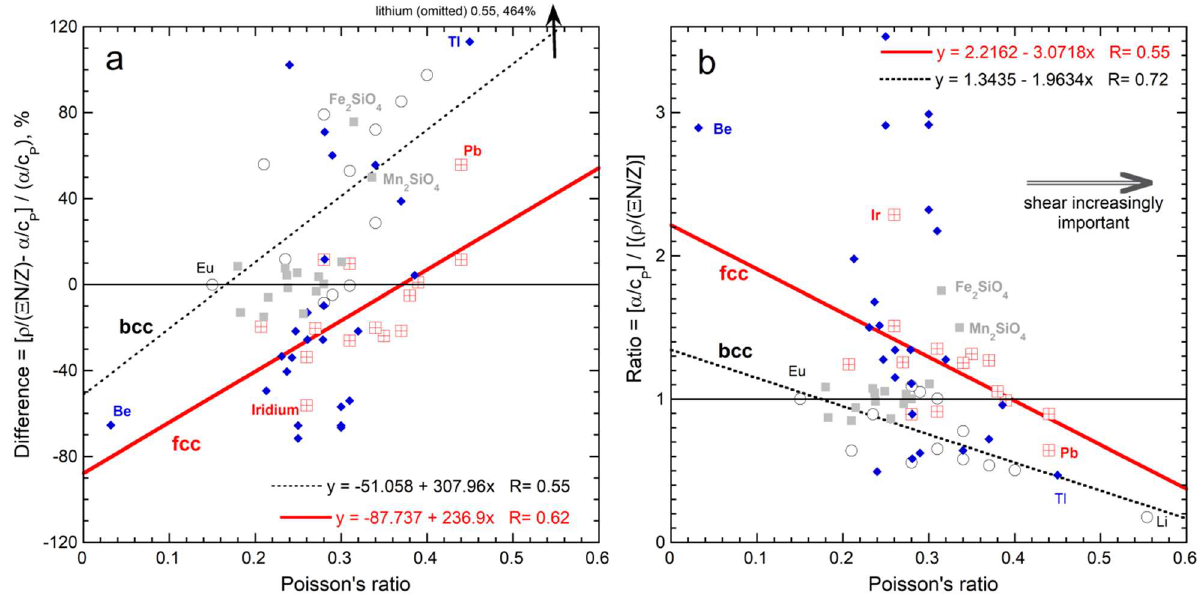
Figure 15. Measures of discrepancy of the data from (46) as a function of Poisson’s ratio. Data on μ from [41,82]; see Figure 14. Fine line = ideal match. Dotted line and circles = bcc. Thick line and squares = fcc. Diamonds = hcp: ( a ) difference = { ρ /( Ξ N/Z) − α / c P }/( α / c P ) in percent; ( b ) ratio of α / c P divided by ρ /( Ξ